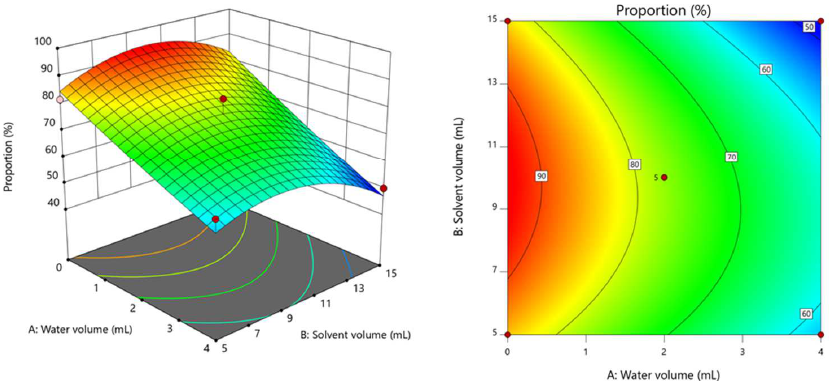
Figure 4. Response surface and contour diagram of R = f (A, B) with a 1.2 mL purification volume.